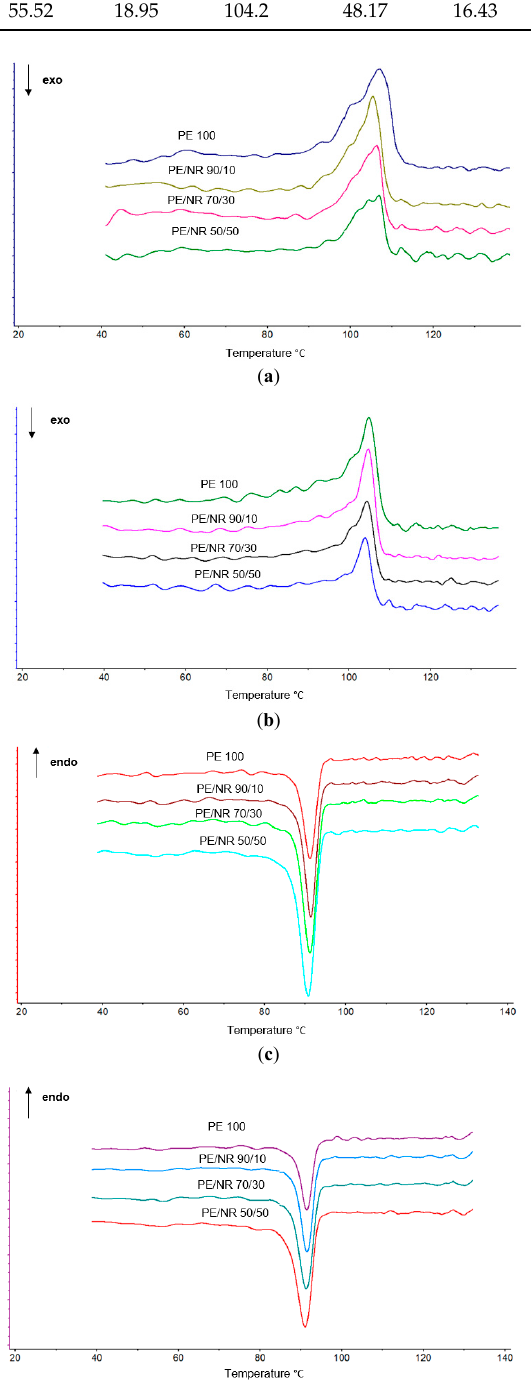
Figure 9. Melting peaks of samples after exposure in the soil: first heating ( a ), second heating ( b ). Cooling peaks of initial samples: first heating ( c ), second heating ( d ). The change in the size of the lamellae is evidence of the biodegradation process. To confirm that the biodegradation process destroys not only NR but also LDPE macromolecules, an indirect assessment of the length of the size of the LDPE lamellae was carried out. A decrease in the length of the lamellae indicates a decrease in molecular weight of LDPE. the evaluation of the length of the lamellae for NR/LDPE composites is shown in Table 7. Table 7. Changing the length of the lamellae after 24 months of exposure in solid. Sample